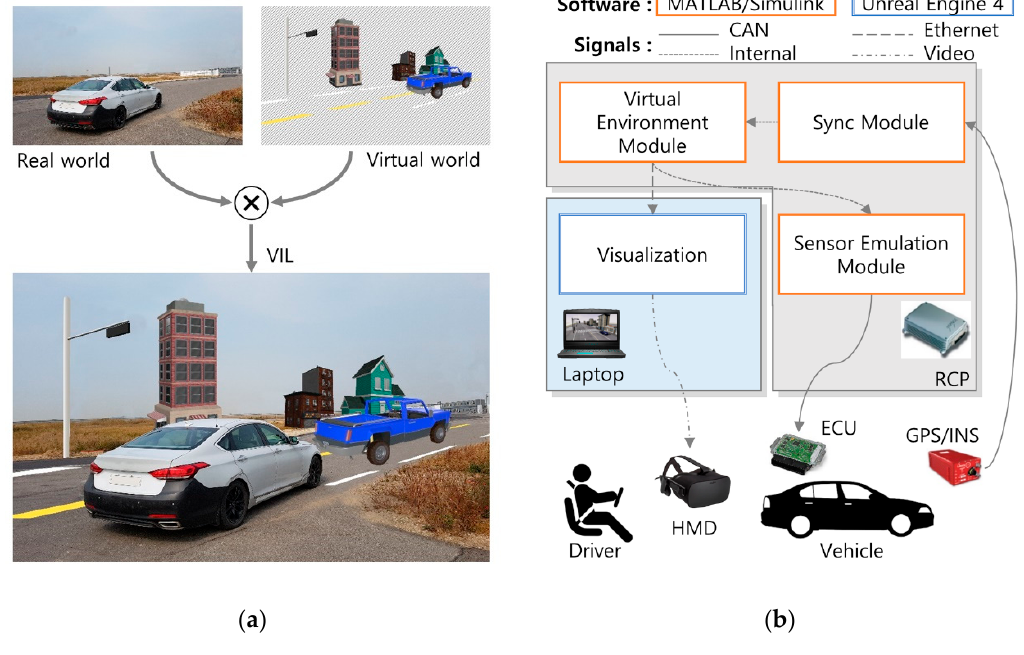
Figure 2. ( a ) Concept of VIL; ( b ) Configuration of VIL.